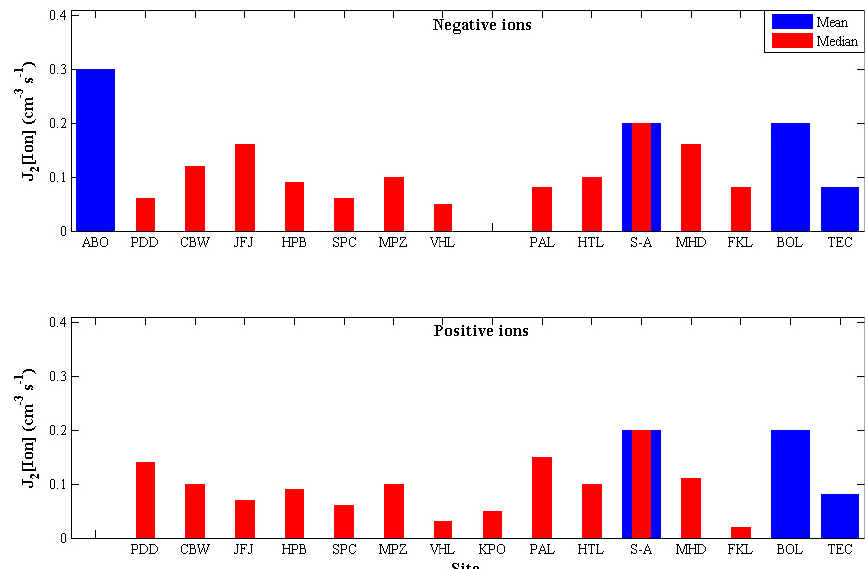
Fig. 7. The mean (blue bar) and median (red bar) J 2 [ion] as a function of site in rural, marine and urban environments for negative ions (top panel) as well as for positive ions (bottom panel). ABO=Aboa, PDD=Puy de Dˆome, CBW=Cabauw, JFJ=Jungfraujoch, HPB=Hohenpeissenberg, SPC=San Pietro Capofiume, MPZ=Melpitz, VHL=Vavihill, PAL=Pallas, HTL=Hyyti¨al¨a, S-A=South-Africa, MHD=Mace Head, FKL=Finokalia, BOL=Boulder,